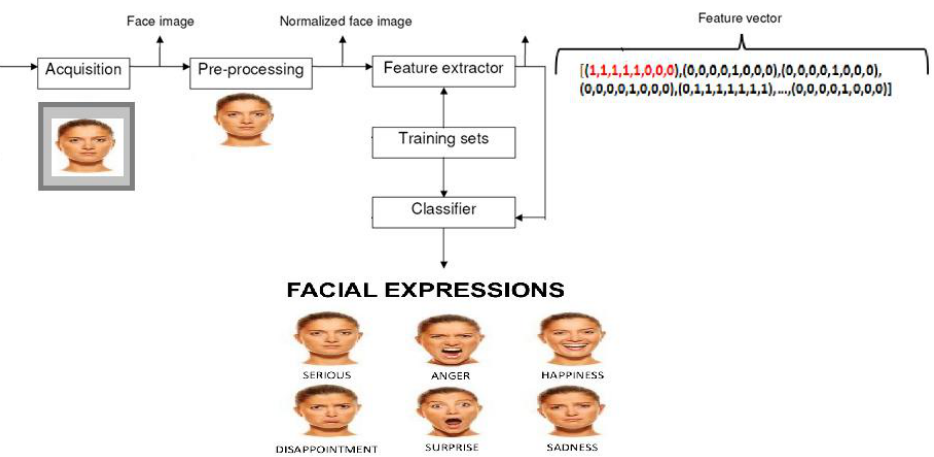
Figure 1. The di ff erent stages of facial expression recognition (FER) Figure 1. The different stages of facial expression recognition (FER) system.